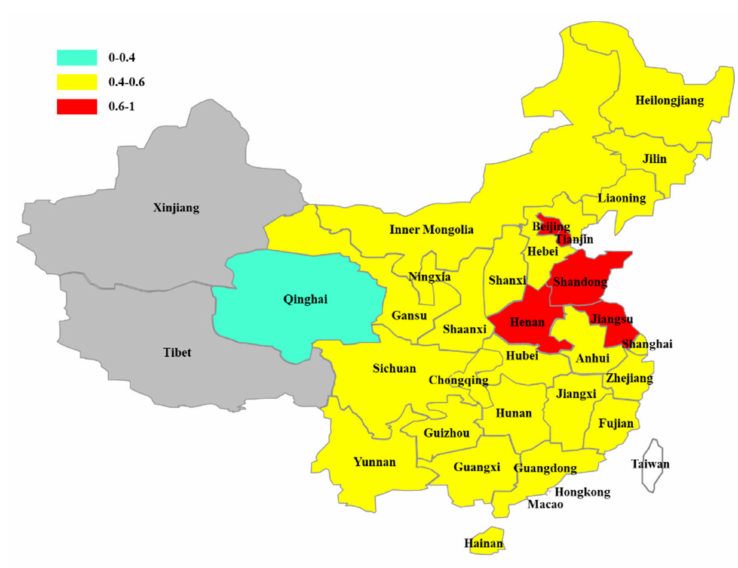
Figure 2. Rural relative poverty rate of provinces and cities in